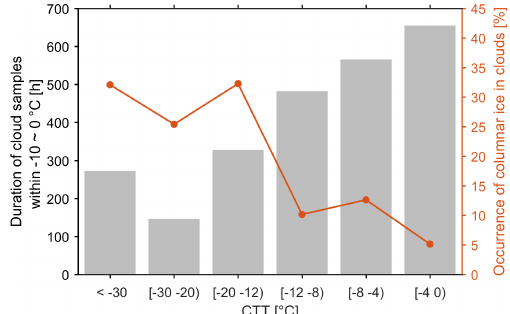
Figure 2. Statistics of (a) temperature ( T column_top ) and (b) rela- tive humidity (RH) at H column_top for all identified columnar-ice- producing cases. H column_top : the highest level where ice columns are detected.